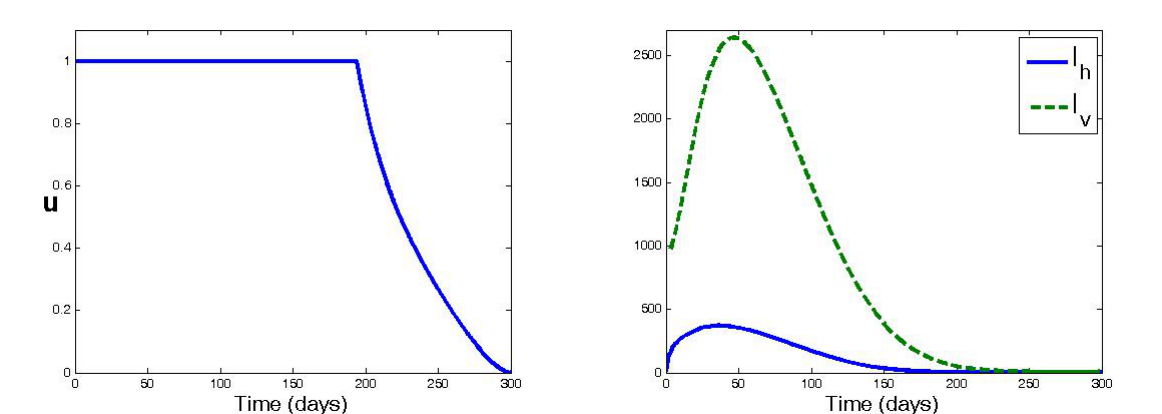
Figure 3. Panel A: The optimal control profile. Panel B: Dynamics of infectious humans I and infectious vector I v as output of the optimal control problem given by Model P (14) and the minimization of the objective functional (15). The parameter values are those specified in the captions of Figures 1 and